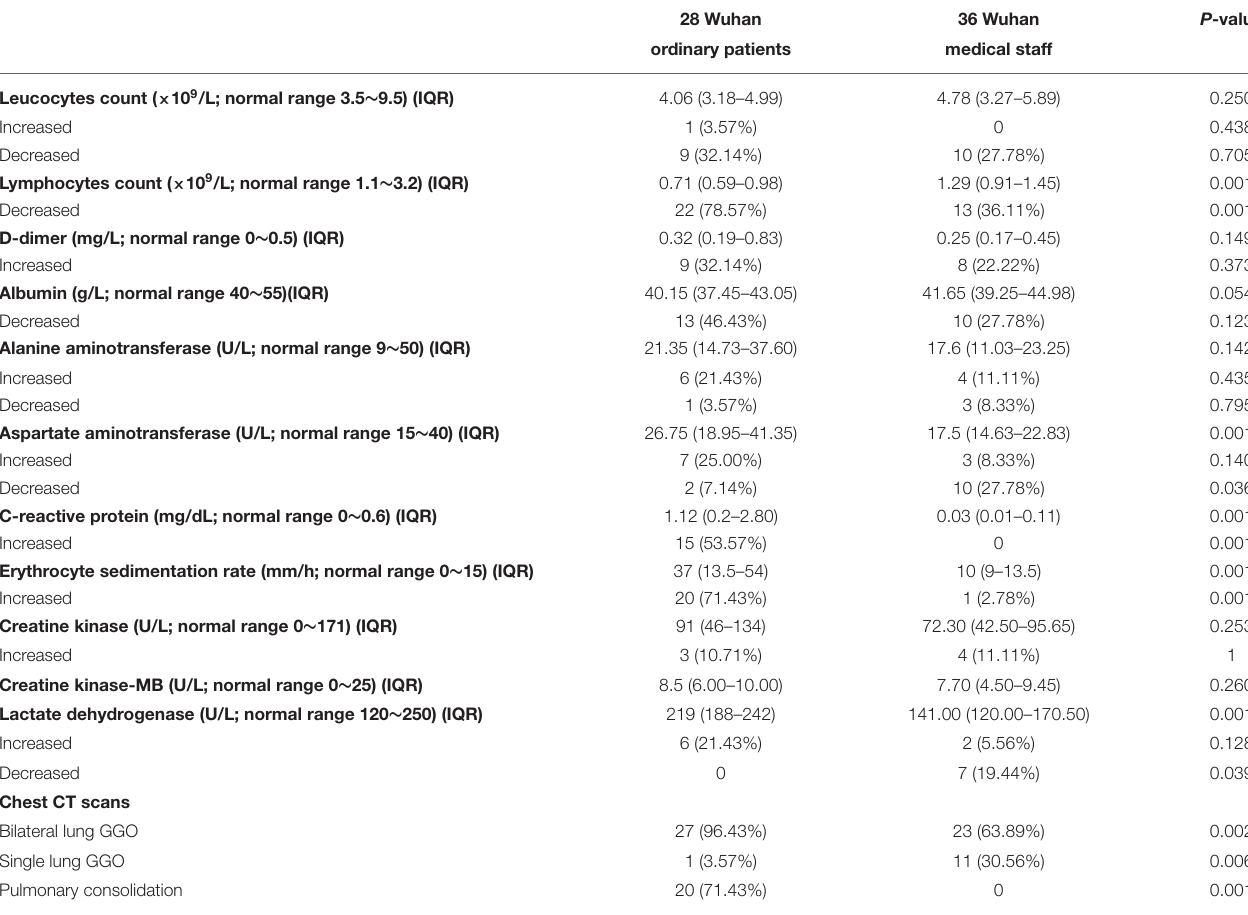
TABLE 2 | Laboratory examination of inpatients with moderate-type COVID-19 from